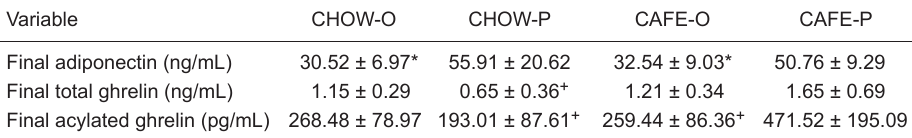
Table 2. Adiponectin, total ghrelin, and acylated ghrelin in the chow-only group (CHOW-O), chow-piogli- tazone group (CHOW-P), cafeteria-only group (CAFE-O), and cafeteria-pioglitazone group (CAFE-P).